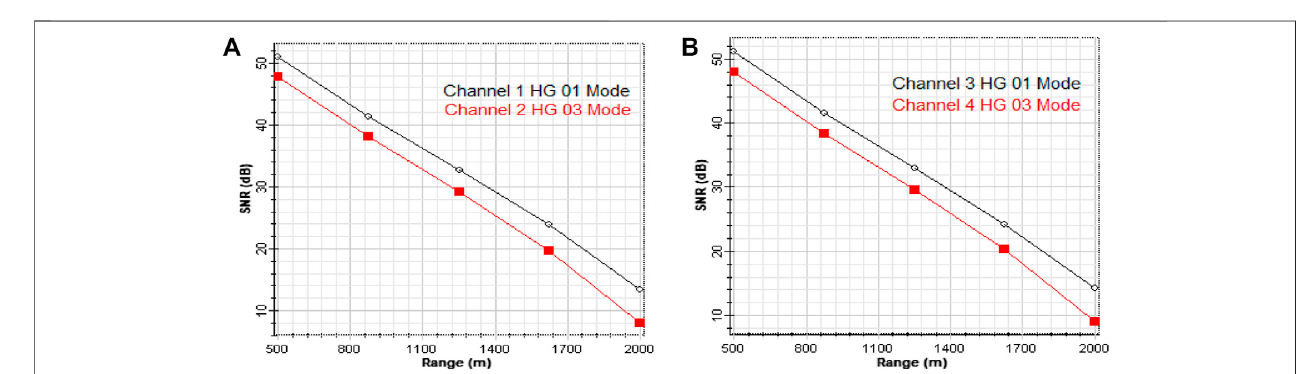
FIGURE 10 | SNR plots for (A) 1931. THz channel and (B) 193.2 THz channel under heavy